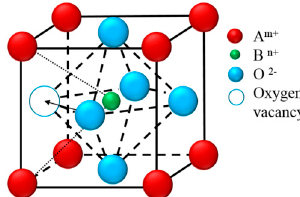
Figure 9. Schematic diagram of a perovskite structure and the triangle consisted of two A/one B atoms showing the vacancy-oxygen ion exchange vector perpendicular to the triangular plane.